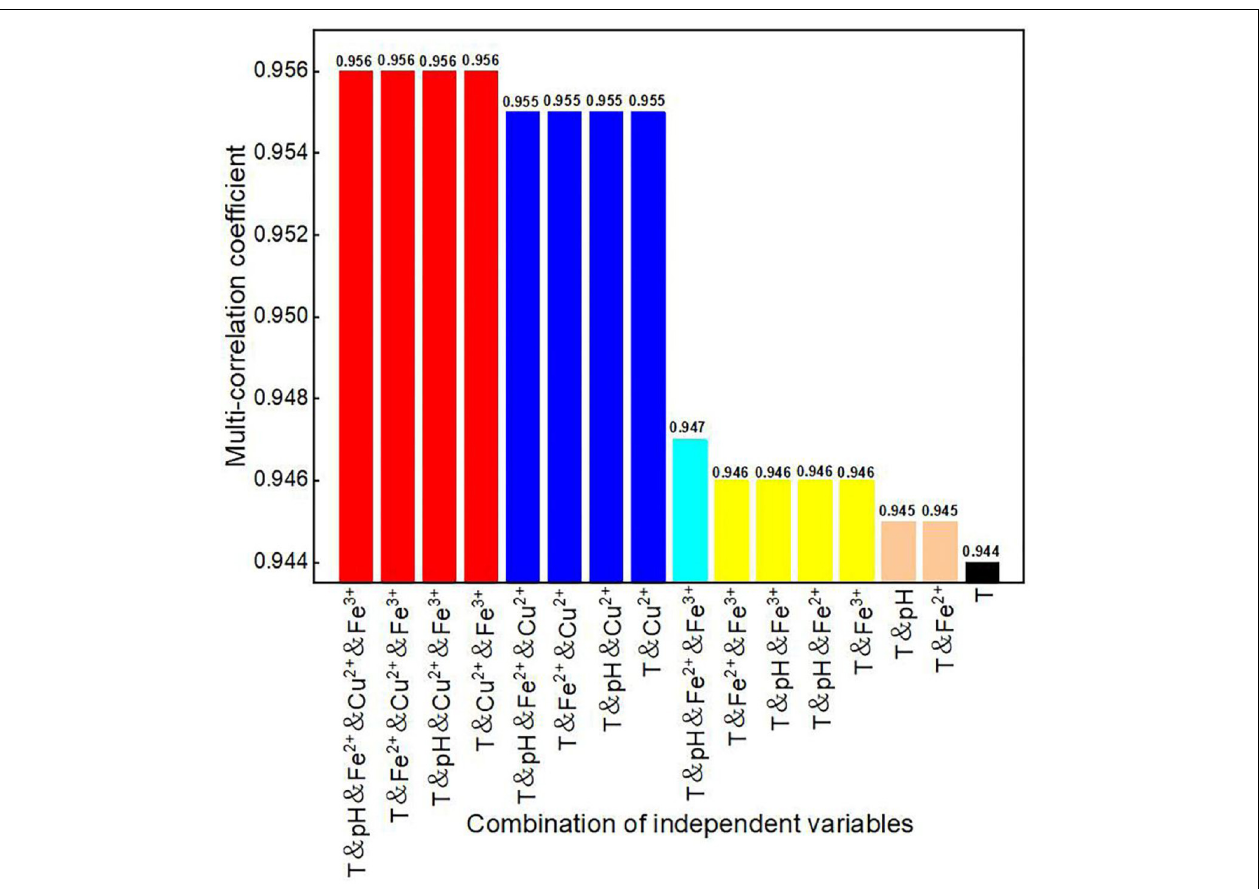
FIGURE 5 | Multi-correlation coefficients of various combinations of process